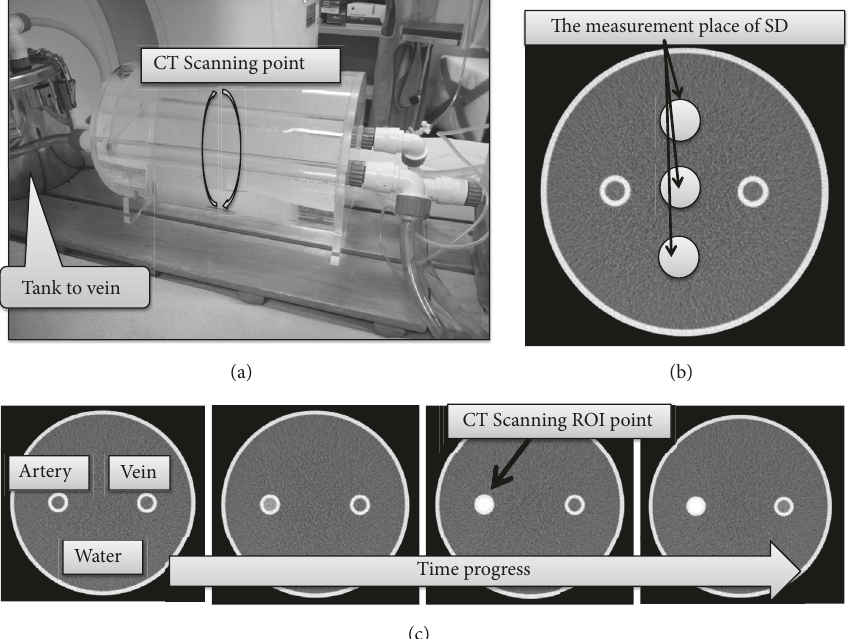
Figure 2: Blood circulation mock phantom. (a) CT scanning point; (b) the measurement location of the image SD; (c) CT scanning region of interest